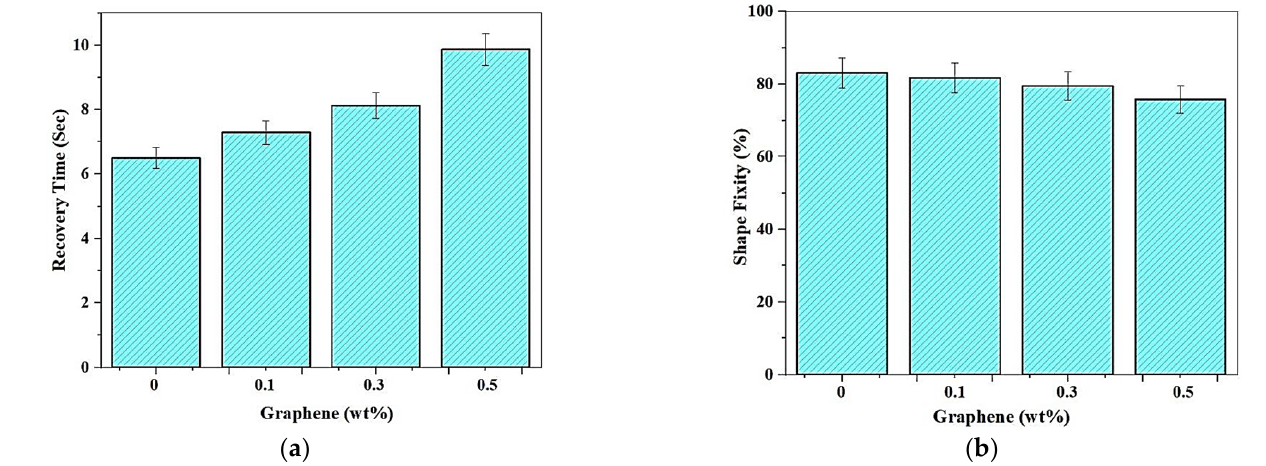
Figure 17 . Variation of ( a ) Recovery times ( b ) Shape fixity with the addition of Graphene nanoparticles .